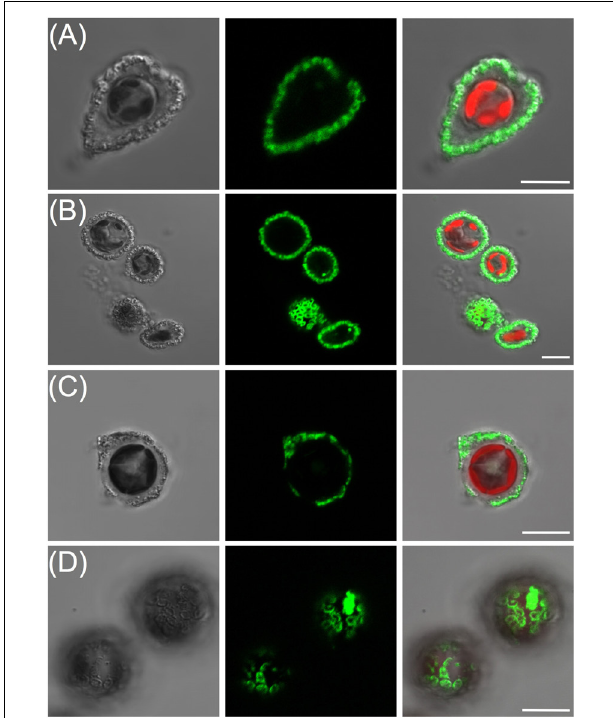
FIGURE 4 | Calcein readily labels holococcolith bearing strains. From left to right panels are DIC, calcein, and overlay of DIC, calcein and chlorophyll. (A) Syracosphaera pulchra showing brightly labeled holococcoliths associated with the organic layer surrounding the cell. (B) Lower confocal section through haploid S. pulchra cells showing intense rings of fluorescence corresponding to holococcoliths imaged at the coverslip surface. (C) Coccolithus braarudii haploid holococcolith stage showing stained holococcoliths and (D) lower confocal section closest to the cover-slip showing ring-like pattern of calcein stained holococcoliths. Scale bars represent 10 µ m.